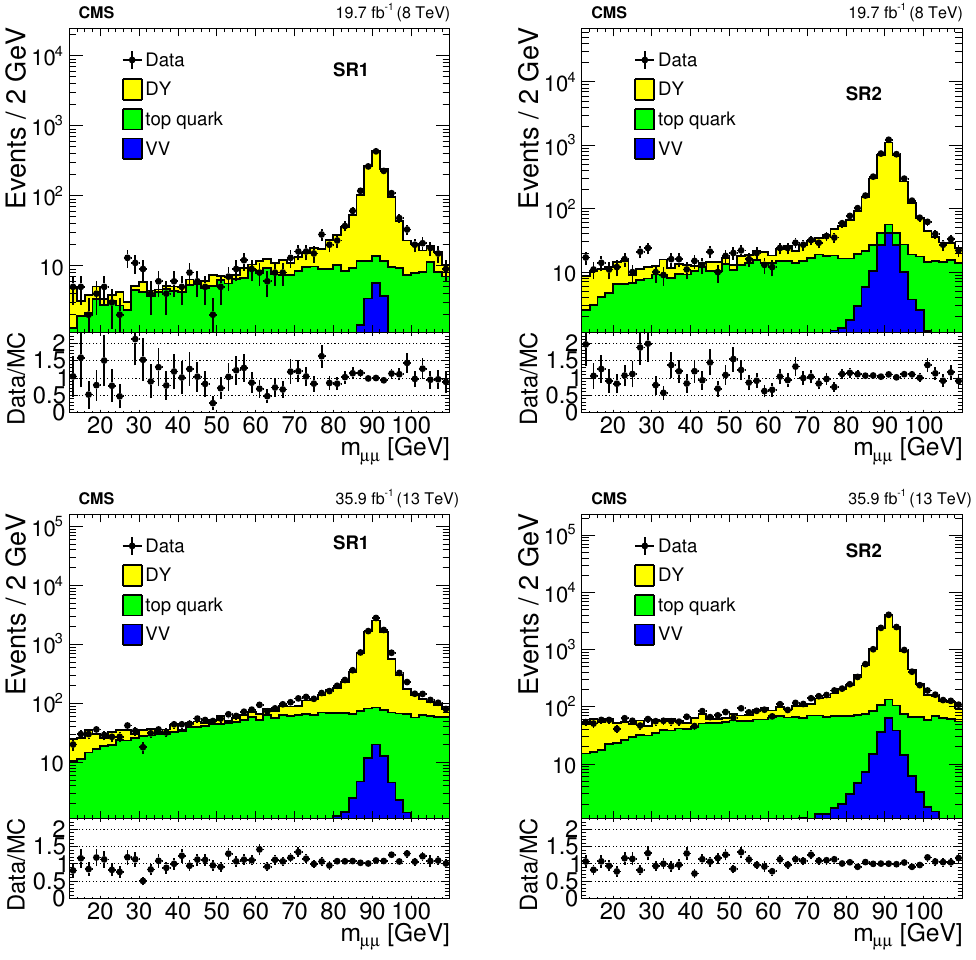
Figure 1 . Upper row: the dimuon mass distribution in SR1 (left) and SR2 (right) in the 8 TeV analysis, with the simulation-based background expectations superimposed. Lower row: the dimuon mass distribution in SR1 (left) and SR2 (right) in the 13 TeV analysis, with the simulation-based background expectations